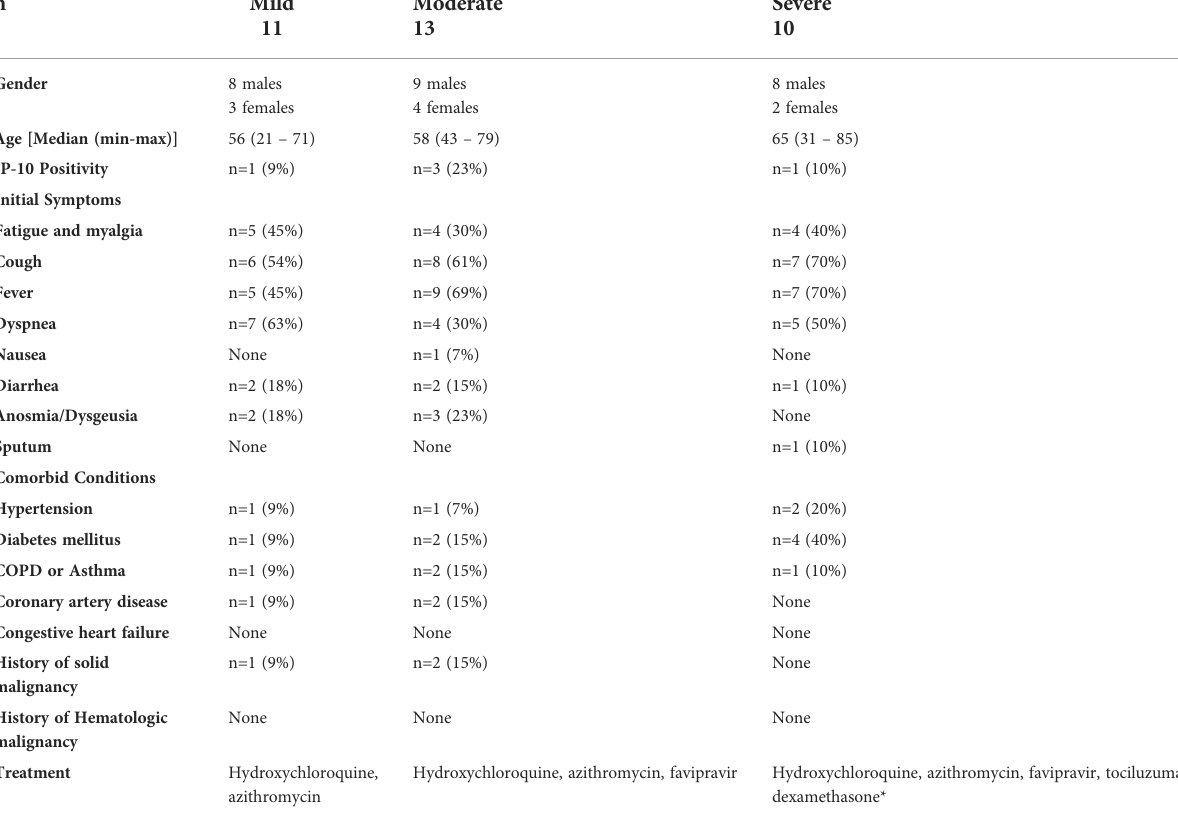
TABLE 1 Demographic characteristics, initial signs and symptomatology.